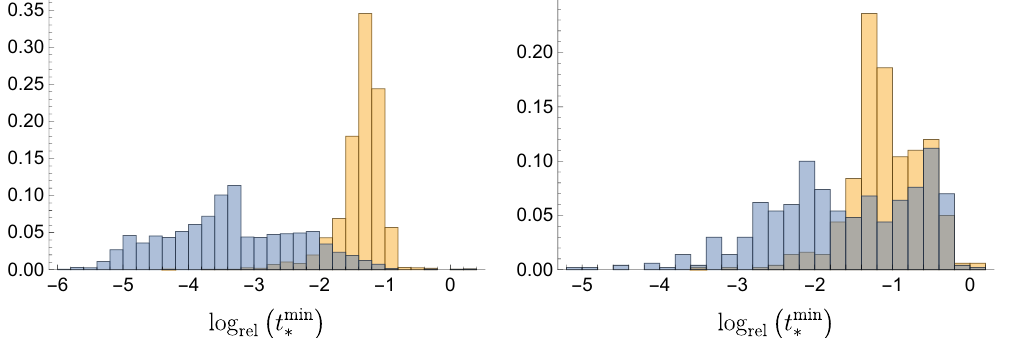
for 2-vev (left panel) and 3-vev (right panel) manifolds, Figure 9 . Logarithmic relative error on t min ∗ using the minimisation procedure described in section 3.2 (yellow bars) and its improved version (blue bars), compared to a full-fledged numerical